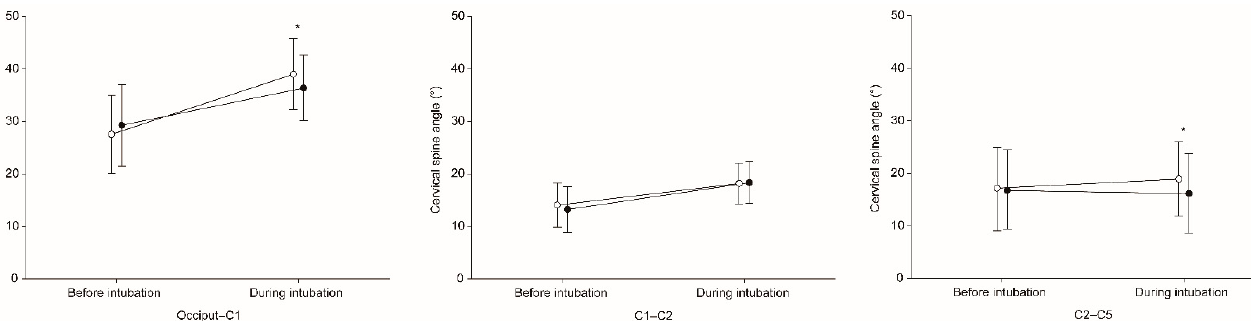
Table 2. Cervical spine motion during intubation.